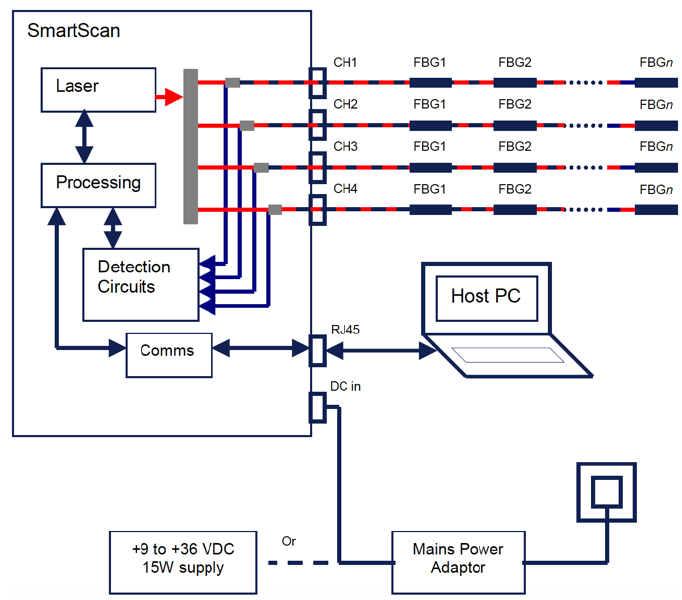
Figure 3. Interrogator logic scheme.